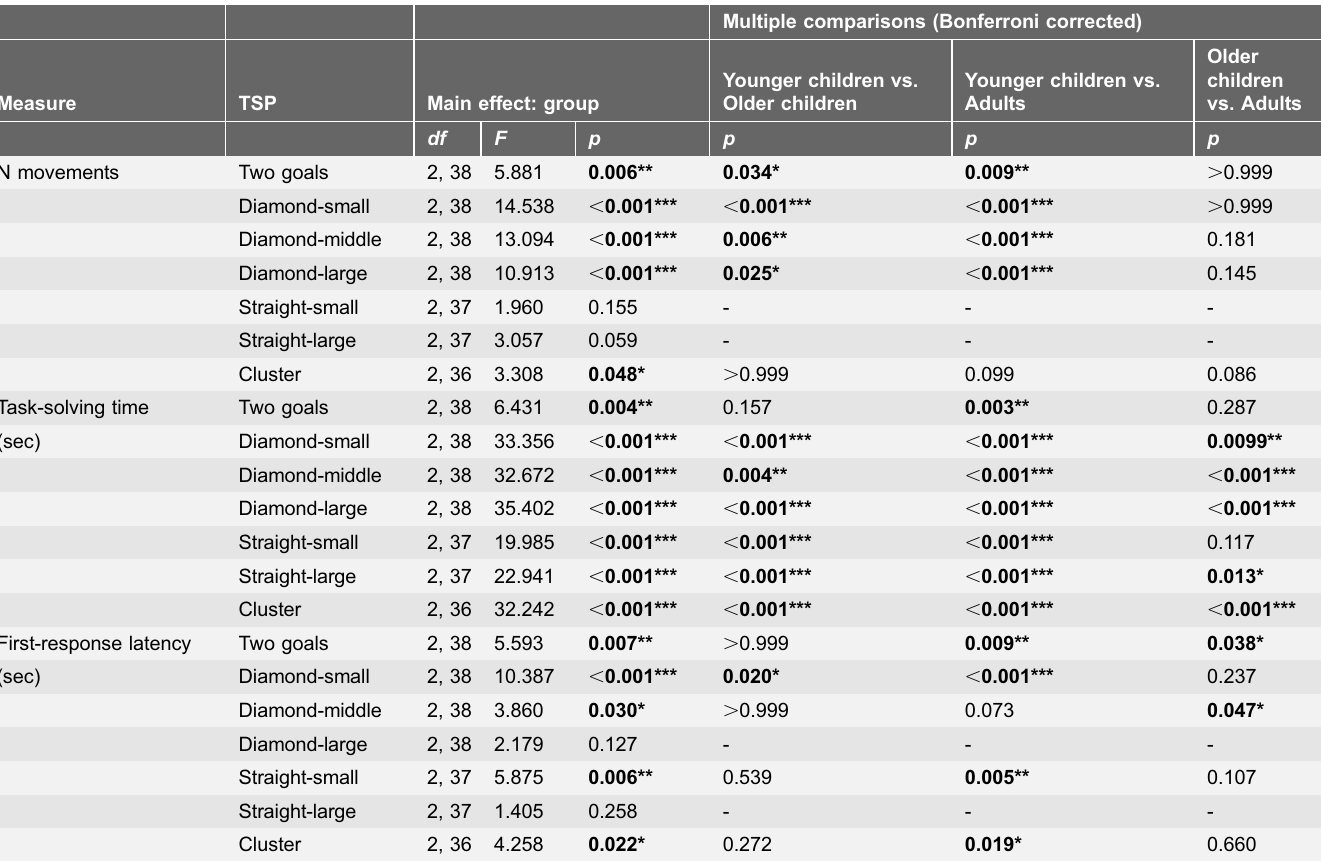
Table 2. Results of one-way ANOVA for each TSP version and measure of